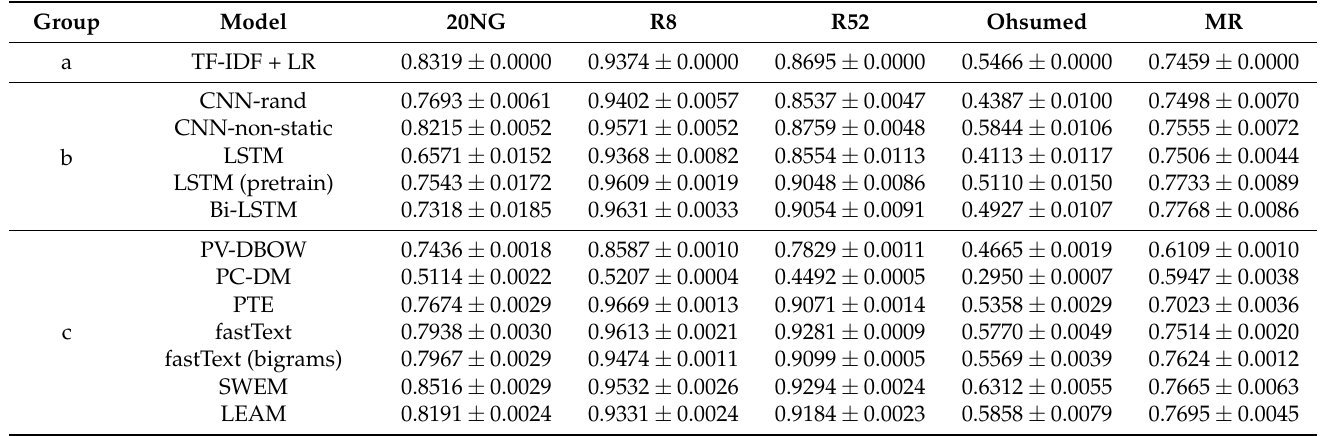
Table 2. Test accuracy on document classification task. We run all models 10 times and report mean ± standard